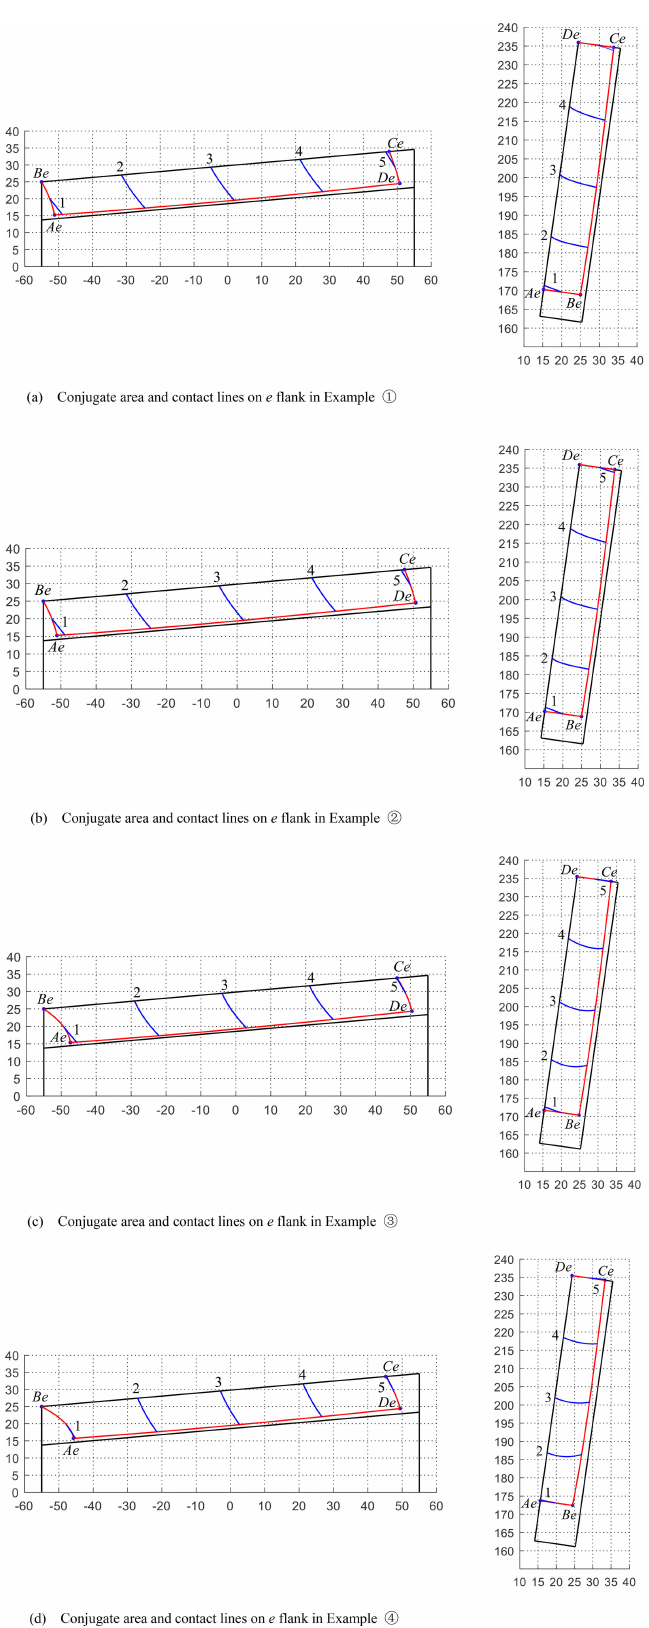
Figure 7. Global meshing performance of the e flank in the